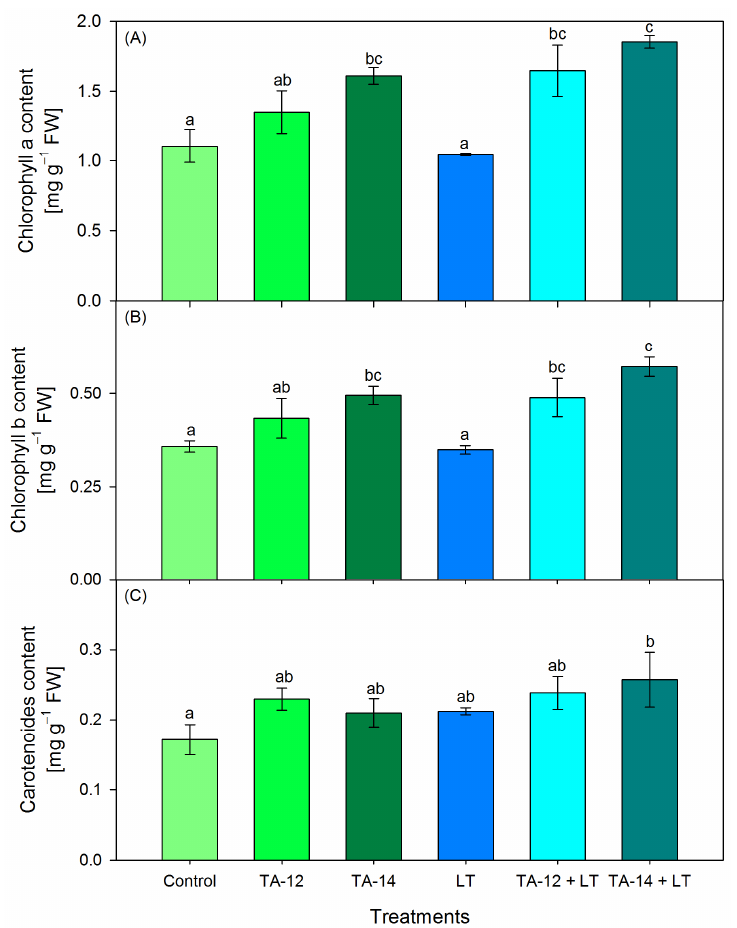
Figure 6. Content of chlorophyll a ( A ), chlorophyll b ( B ) and carotenoids ( C ) in pea sprayed with TA-12 or TA-14 and subjected to low temperature (−1 °C, LT) for 24 h. Data are mean values ± SE. Different letters designate statistically significant difference at p <